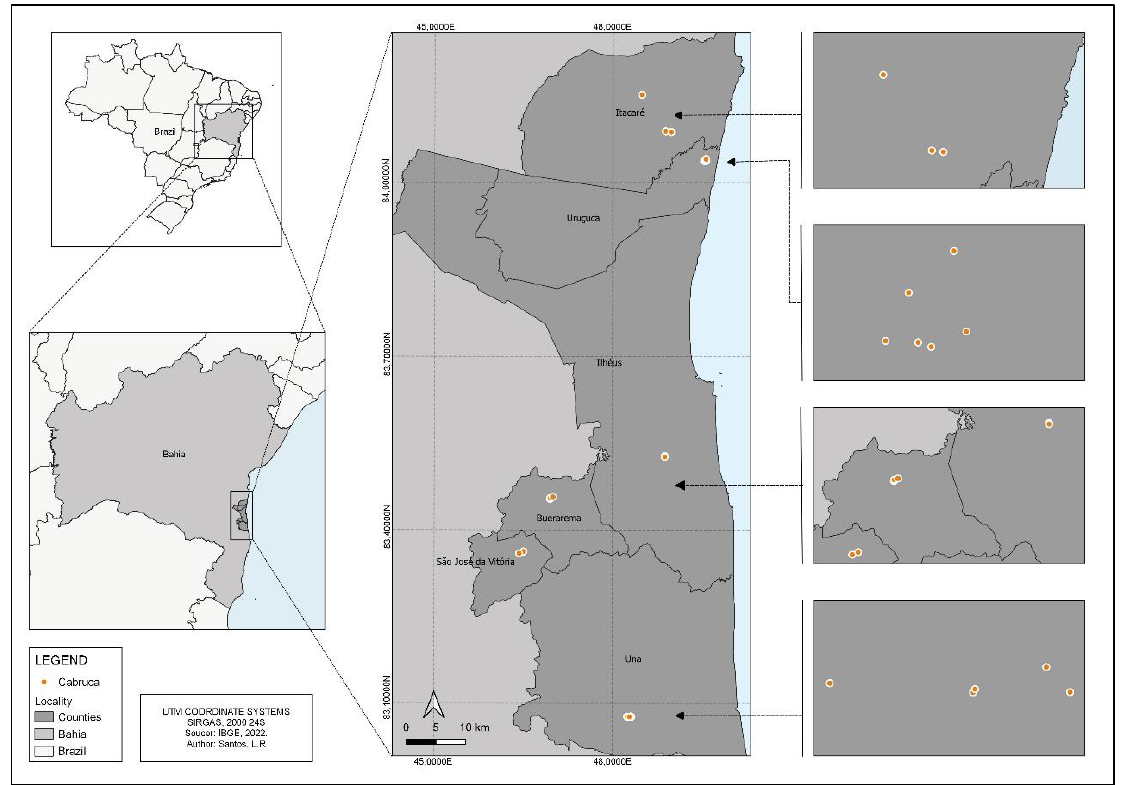
Figure 1. Map with sites sampled in the six municipalities in the southern region of Bahia in cabruca areas. The red circular dots are the sites sampled.